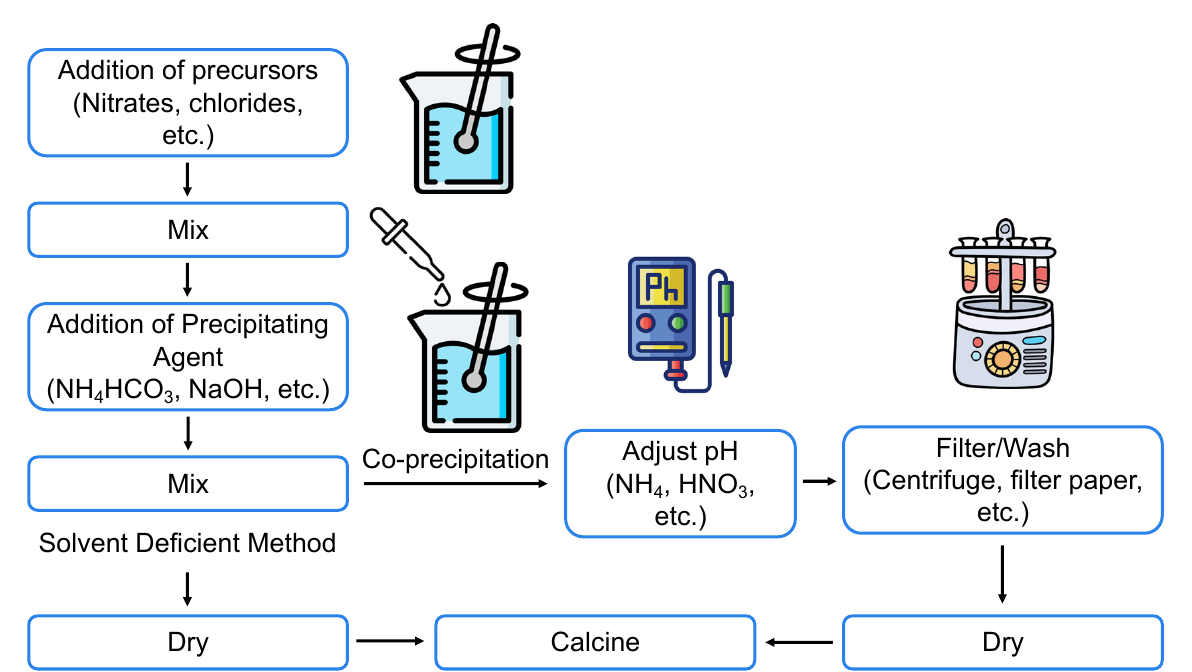
Figure 3. Flow chart of ceramic nanoparticle synthesis using co-precipitation and solvent deficient method. [Icons to illustrate the steps were created by Freepik from Flaticon.com].